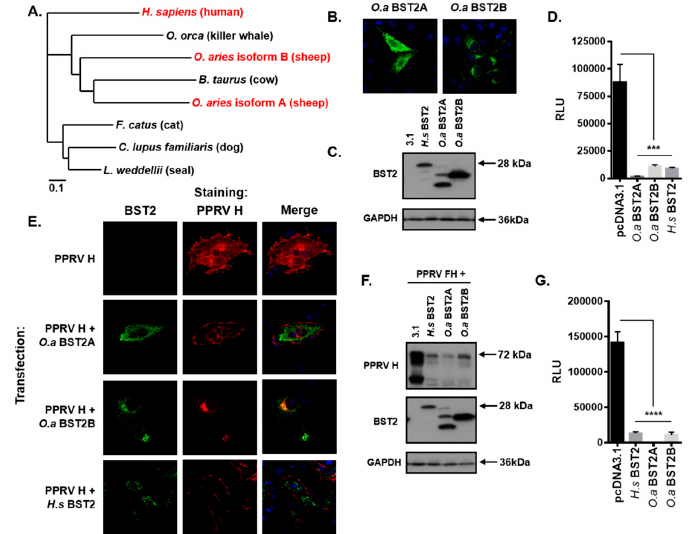
Figure 5. Morbilliviruses are broadly targeted by mammalian BST2 proteins. ( A ) Phylogenetic analysis of the amino acid sequences of a range of mammalian BST2 proteins including those examined in this study (highlighted in red). ( B / E ) Vero-hSLAM cells, cotransfected with the indicated pcDNA3.1-based expression constructs, and analyzed by immunofluorescence microscopy. Representative micrographs are shown together with merged images to demonstrate colocalization of labeled proteins. ( C / F ) HEK293T cells transfected with pcDNA3.1-, H.s BST2, O.a BST2A, or O.a BST2B, were cotransfected with either 500 ng of pcDNA3.1 ( C ) or 250 ng each of pcDNA3.1 peste des petits ruminants virus